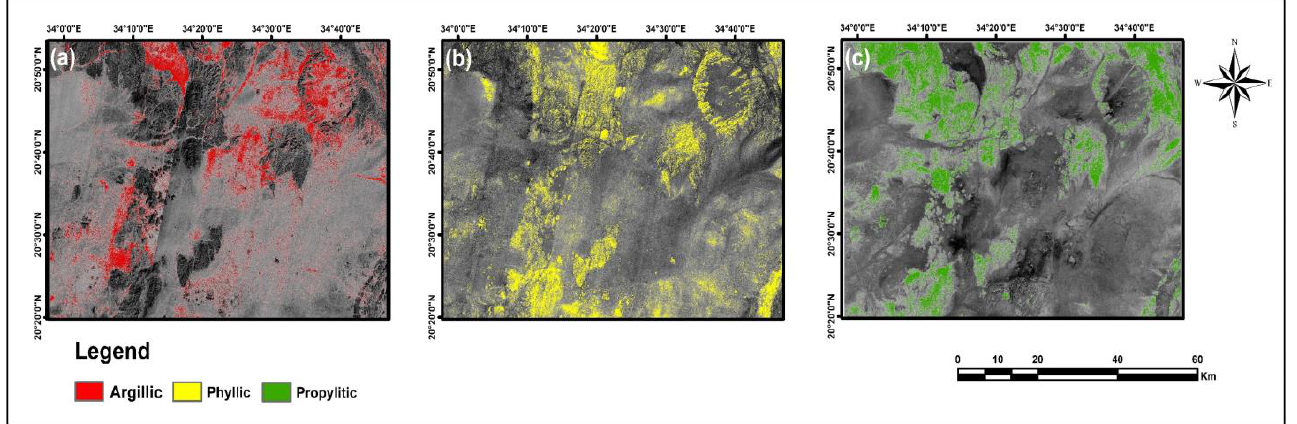
Figure 7. The RBD images derived from ASTER SWIR bands show the spatial distribution of differ- ent alteration zones in colored pixels: ( a ) RBD1; ( b ) RBD2; ( c ) RBD3. alteration zones in colored pixels: ( a ) RBD1; ( b ) RBD2; ( c )